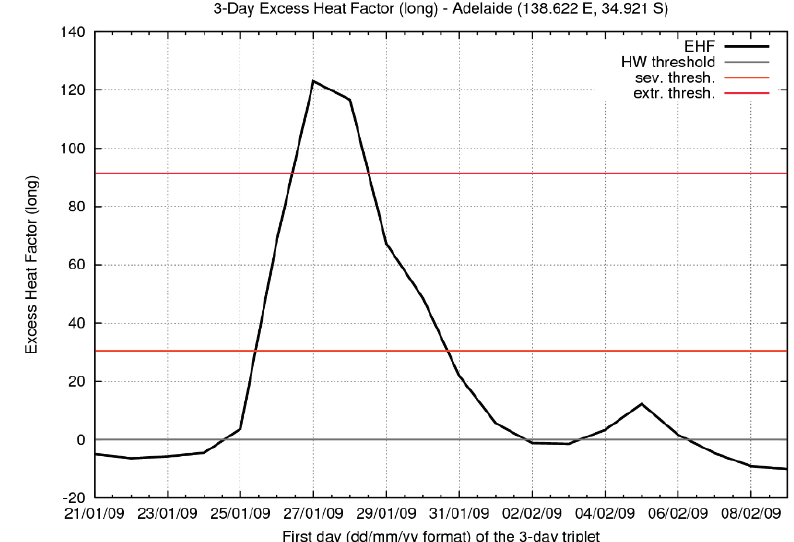
Figure 14. EHF for Adelaide (South Australia) across the period 21–23 January to 9–11 February 2009 (black line). The horizontal axis indicates the first day of each TDP. The horizontal grey line marks the threshold for a low-intensity heatwave ( i.e. , zero EHF), while the orange and red horizontal lines mark the thresholds for severe and extreme heatwaves respectively. Data are derived from interpolating gridded analyses of EHF. T = 24.9 °C, with the severity threshold being 30.5 K 2 95